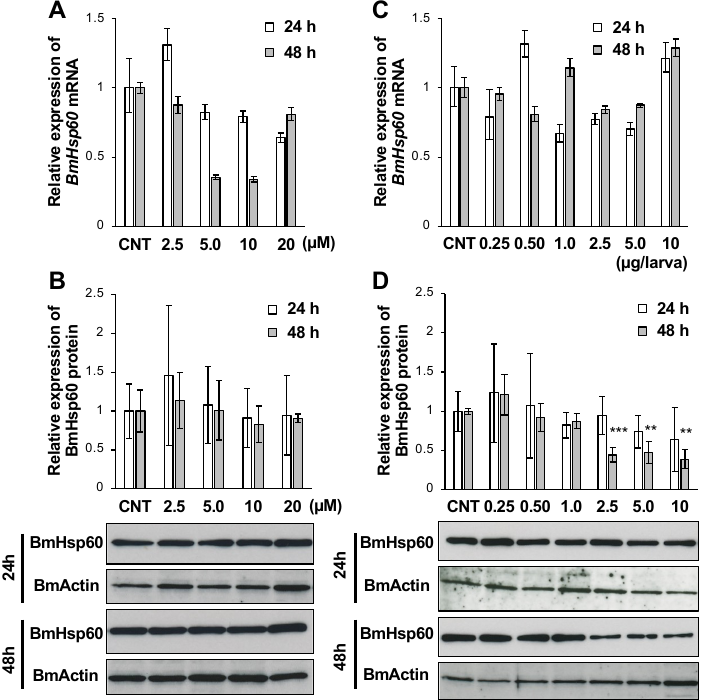
Figure 5. mRNA and protein expression levels of BmHsp60 in the fat body after 20E treatment. ( A , B ); Cultured fat bodies were treated with 0, 2.5, 5.0, 10, or 20 µ M 20E for 24 or 48 h. Controls (CNT) were treated with only 10% isopropanol. mRNA expression of BmHsp60 examined by qRT-PCR after 24 or 48 h is plotted as relative quantification (RQ) values compared with levels in the CNT ( A ). Error bars indicate relative minimum/maximum expression levels against mean RQ values. 18S rRNA was used as the endogenous control. Expression of BmHsp60 was examined by immunoblotting after 24 or 48 h ( B ). Aliquots (5 µ g) of the fat body lysate samples were separated by 15% SDS-PAGE and immunoblotted. BmActin was used as an endogenous control. The band intensity of BmHsp60 was calculated using ImageJ and normalized against the band intensity of BmActin; relative expression levels compared with CNT levels are plotted. Error bars indicate SD ( n = 12). ( C , D ); Day 4 fifth instar larvae were treated with 0, 0.25, 0.50, 1.0, 2.5, 5.0, or 10 µ g/larva 20E, and fat bodies were dissected after 24 or 48 h. Controls (CNT) were injected with only 10% isopropanol. mRNA expression